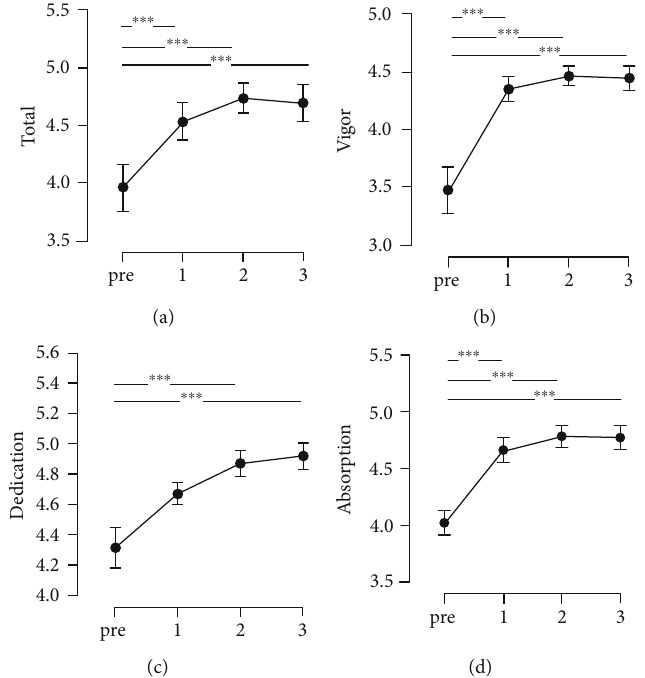
Figure 3: Results of the Sport Engagement Scale total score and each factor score through each intervention. y -axis: raw score of SES; x -axis: intervention timeline. Error bars represent standard error (SE). (a) Total score of SES; (b) vigor; (c) dedication; (d) absorption. ∗∗∗ pbonf < 0 : 001 .